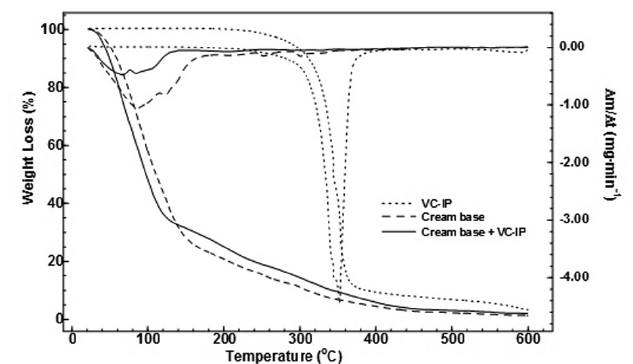
FIGURE 7 - TG/DTG curves of cream base, VC-IP and cream base with VC-IP samples obtained in a mixture of air (20 mL min -1 ) and N2 (50 mL min -1 ) under a dynamic atmosphere and at a heating rate of 10 ºC min -1 .